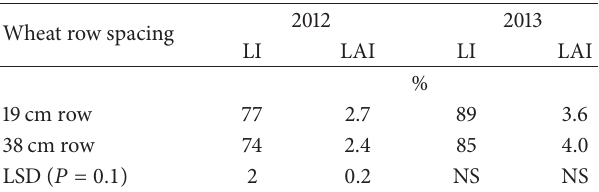
Table 1: Light interception (LI) and leaf area index (LAI) of wheat planted in 19 and 38 cm wide rows.